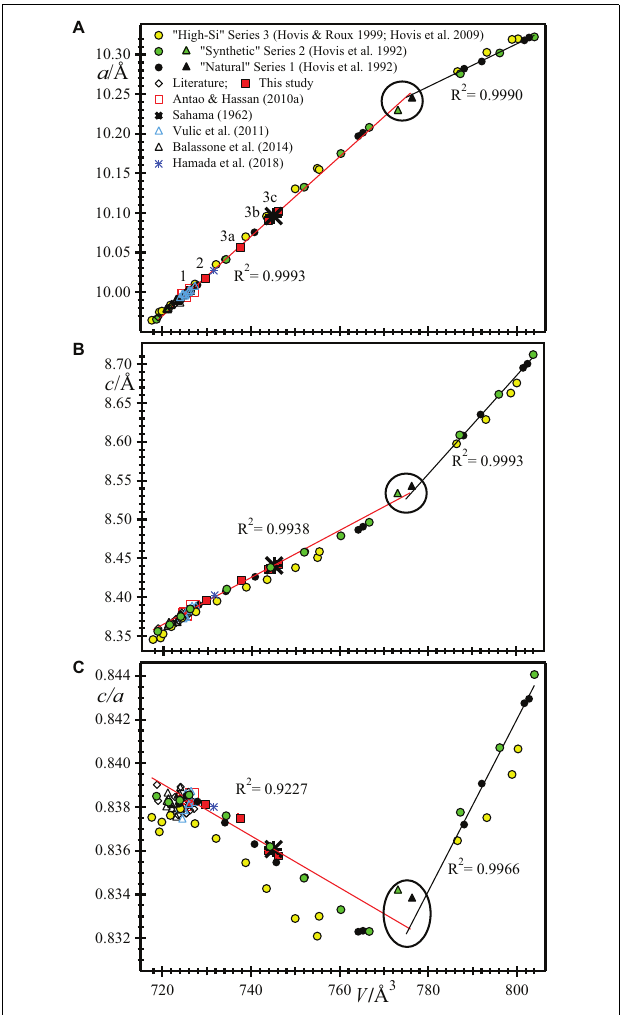
FIGURE 5 | Linear trends among unit-cell parameters for nepheline-kalsilite solid solutions. The red trend lines were calculated using data from this study and from Antao and Hassan (2010b); they contain 8 data points. The linear a vs . V plot in (A) shows a high correlation factor ( R 2 = 0.9993) with very little scatter of the data points from the “Literature” (these references are given in the text), followed by c vs. V in (B) with R 2 = 0.9938, and c / a vs . V in (C) with R 2 = 0.9227. The agreements in trends for all natural samples are better than those for the three different ion-exchange series, but the agreement for the synthetic series 3 is not so good. Two tetrakalsilite samples are indicated by solid triangles near the intersection of the two straight lines (circled points). The black straight line is fitted to the four “natural” kalsilite series 1 samples and their R 2 values are given as inserts. For comparison to nepheline data, a unit-cell values for kalsilite are doubled and those for tetrakalsilite are halved.